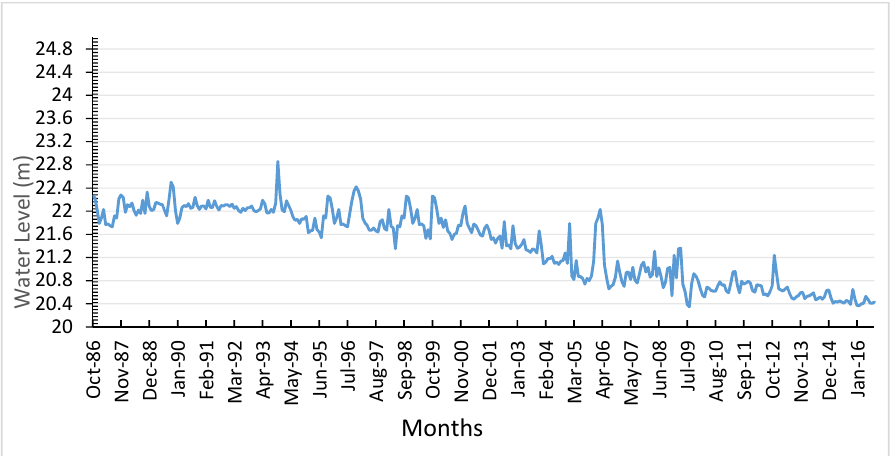
Figure 5. Water level data for 30 years at station 1 (1986–2016).